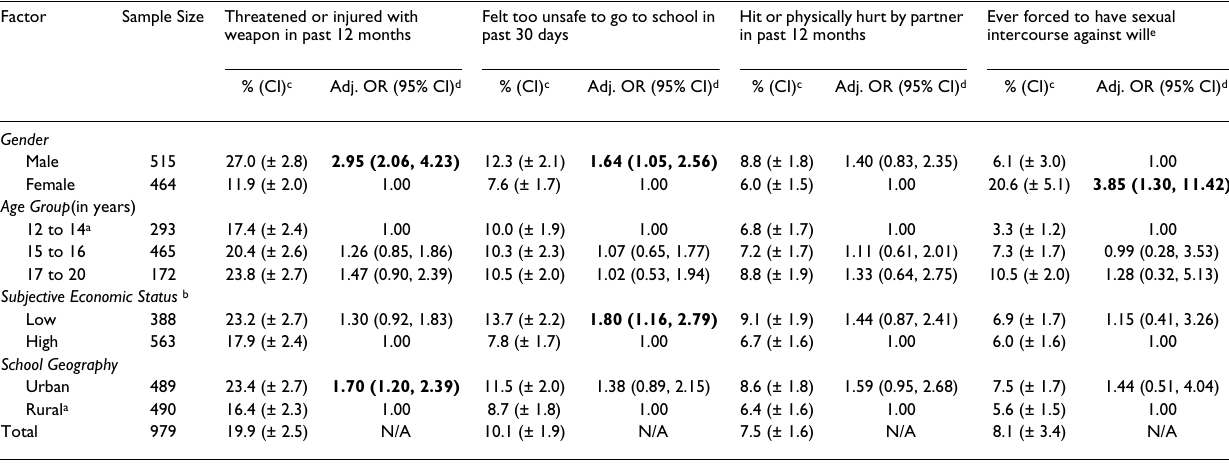
Table 2: Prevalence of victimization among eighth and ninth grade secondary students attending public schools in a central region of El Salvador by socio-demographic characteristics, 1999 Factor Sample Size Threatened or injured with Felt too unsafe to go to school in Hit or physically hurt by partner Ever forced to have sexual weapon in past 12 months past 30 days in past 12 months intercourse against will